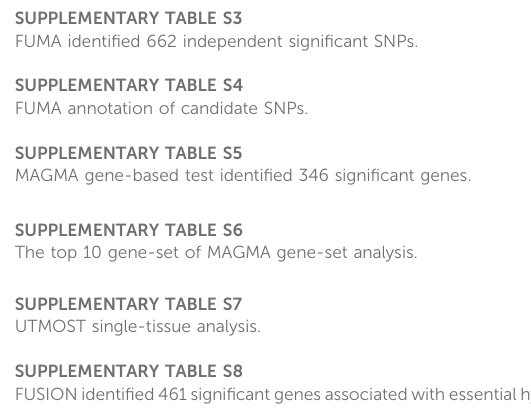
SUPPLEMENTARY TABLE S4 FUMA annotation of candidate SNPs.